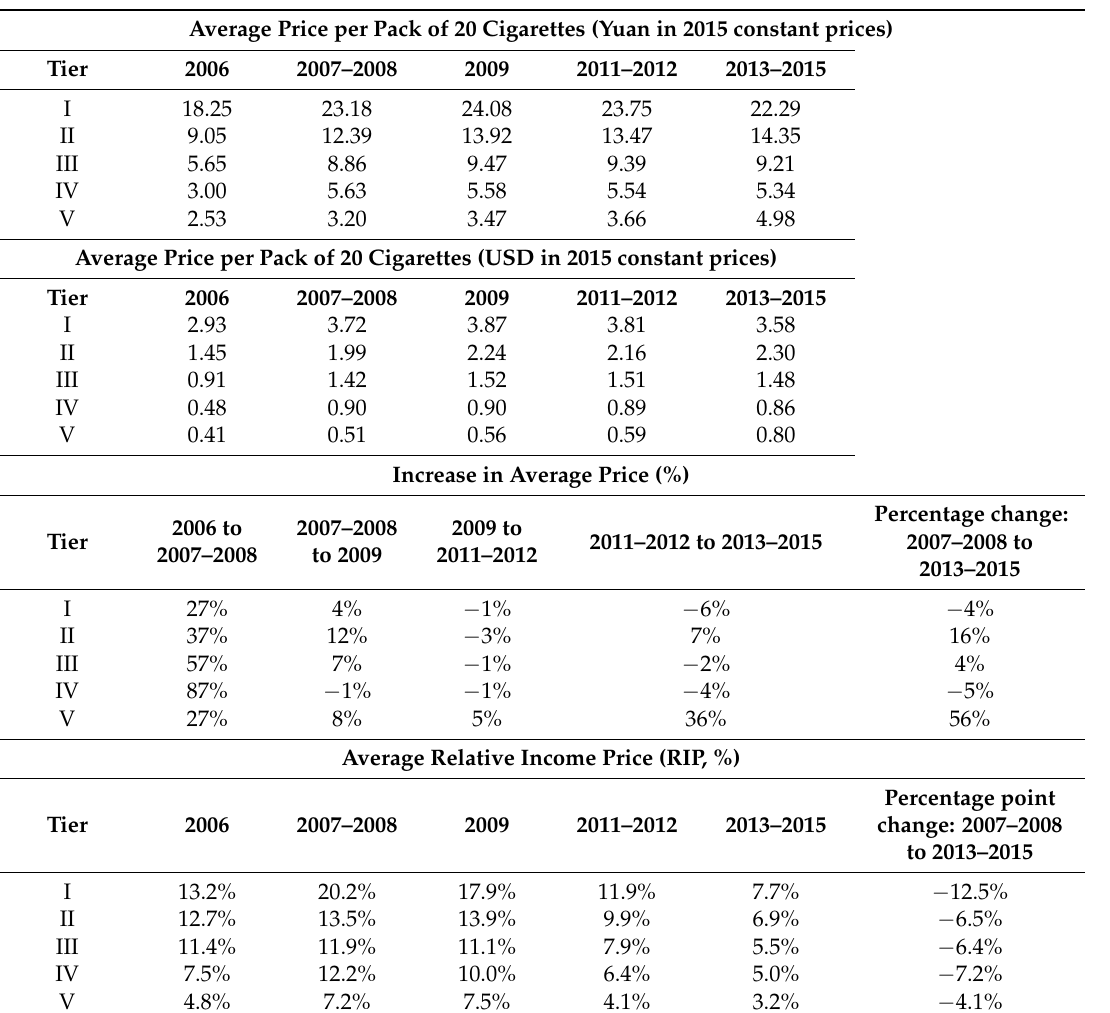
Table 3. Average self-reported price of cigarettes per pack of 20 pieces and average Relative Income Price (RIP) of cigarettes in China, 2006 to